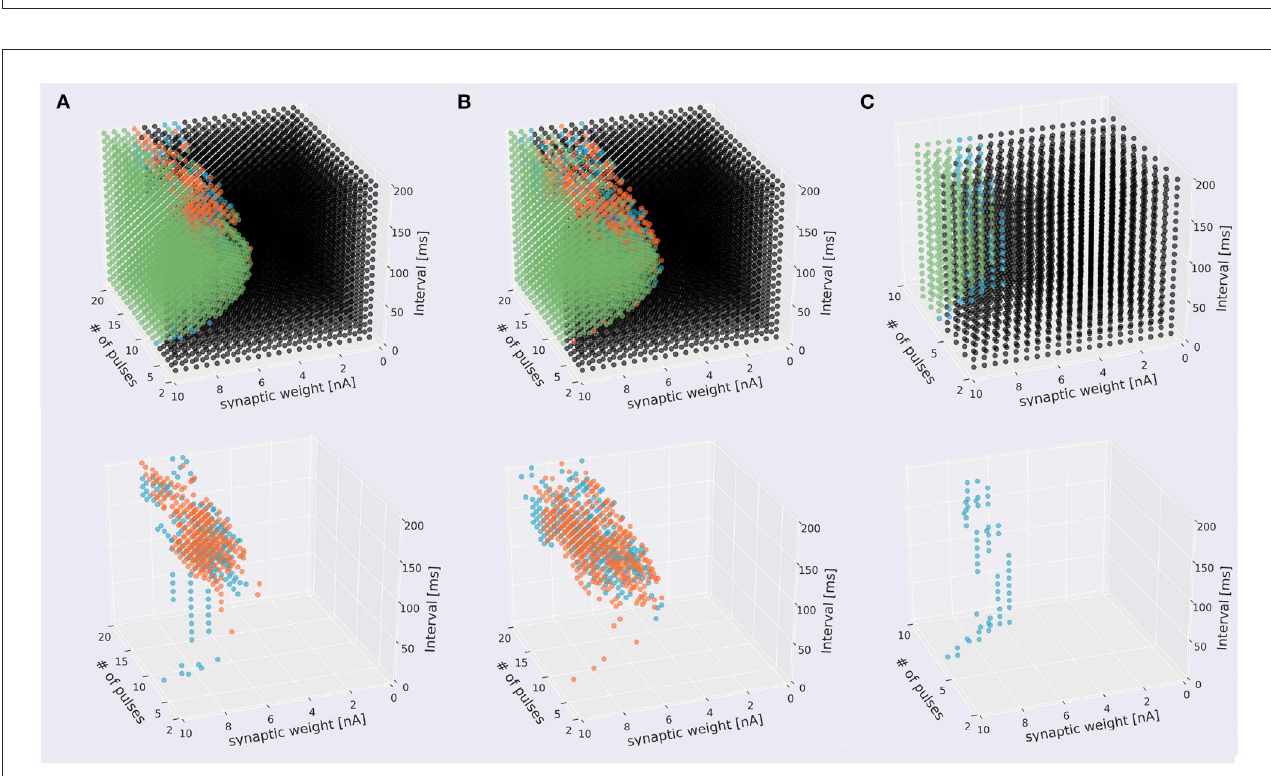
FIGURE5 Scatter plots of stimuli that evoked different responses. The top panels four types of stimuli that evoked somatic response when stimulated in IN direction (blue), OUT direction (orange), both directions (green), and that did not evoke responses (black). The bottom figures omitted the plots of non-discriminated sequences. (A) Sequences starting from spiny dendrite. A 2,328 sequences induced spikes in both stimulus directions, 199 sequences were IN-only, 322 sequences were OUT-only, and 4,751 did not induce spikes in both directions. (B) Sequences starting from smooth dendrite. A 1,779 sequences caused spikes in both directions, 304 sequences were IN-only, 381 sequences were OUT-only, and 5,136 did not induce spikes in both directions. (C) Sequences starting from main dendrite. A 286 sequences induced spikes in both directions, 59 sequences were IN-only, and no sequences were OUT-only, A 2,455 sequences did not cause spikes in both